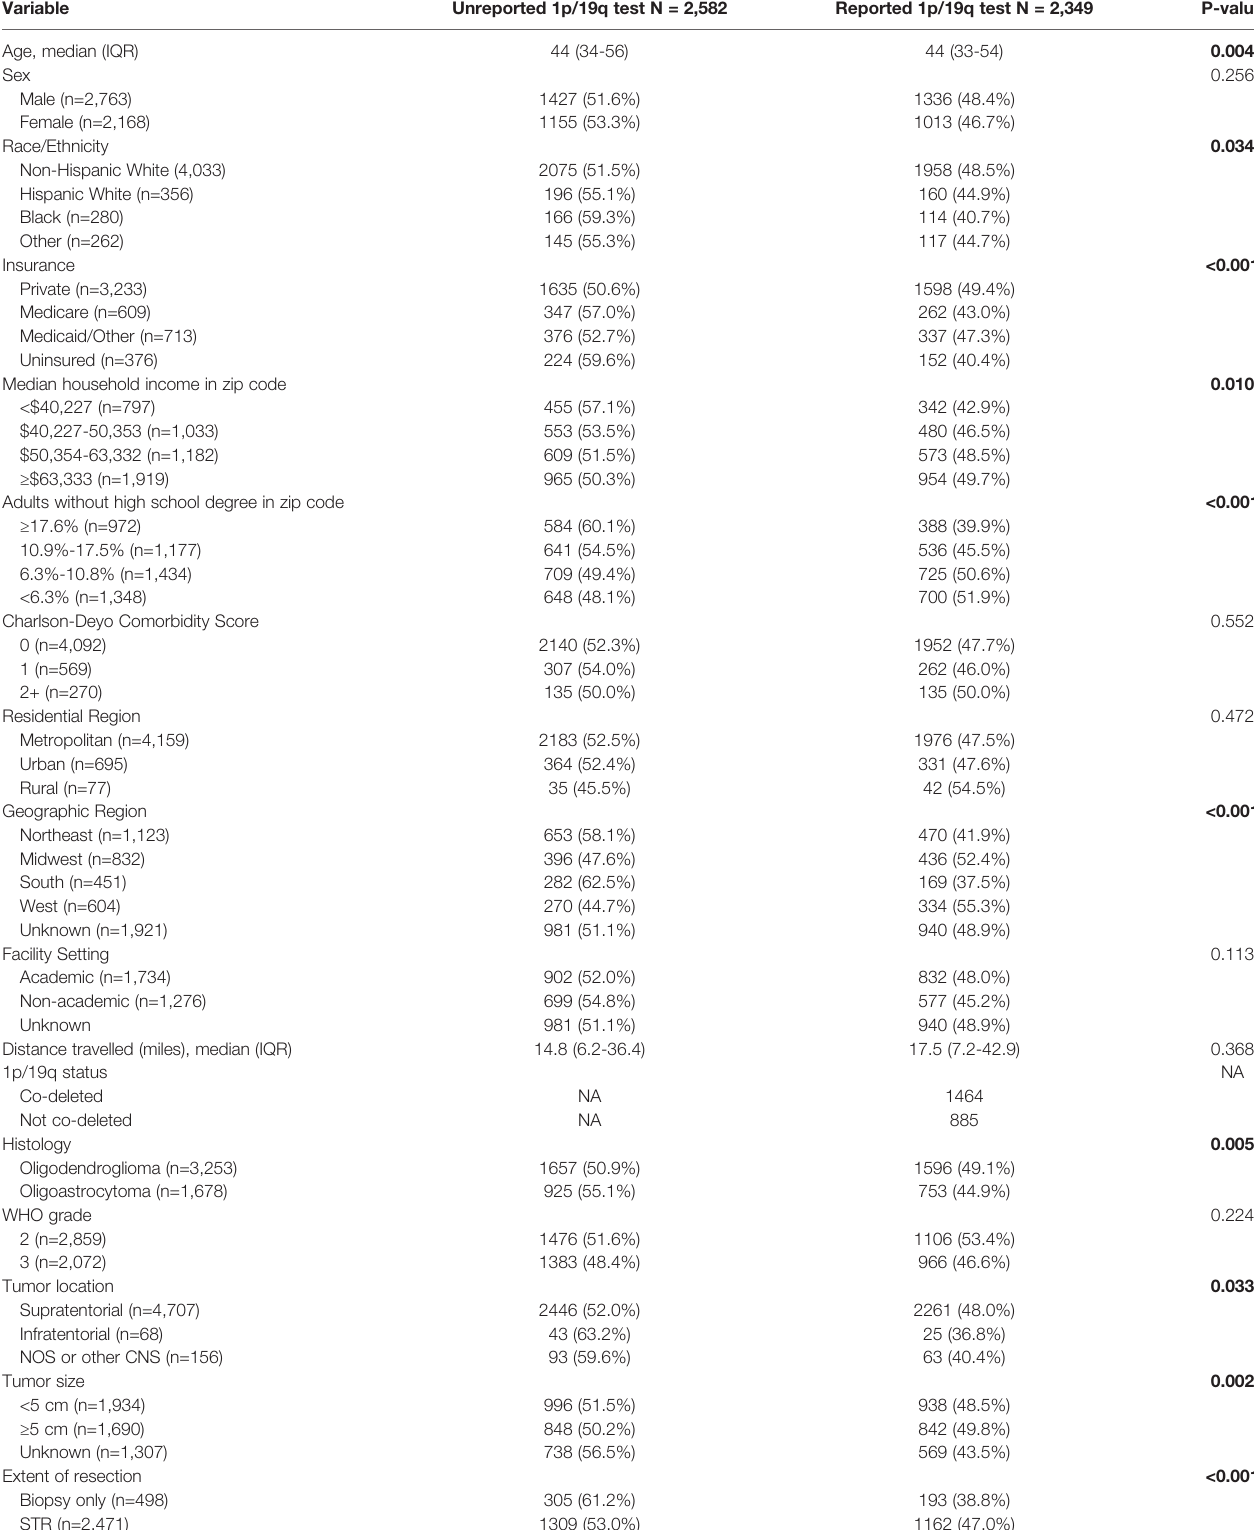
TABLE 1 | Characteristics of patients with and without a reported 1p/19q codeletion test diagnosed from 2011-2015. Frequencies and proportions are